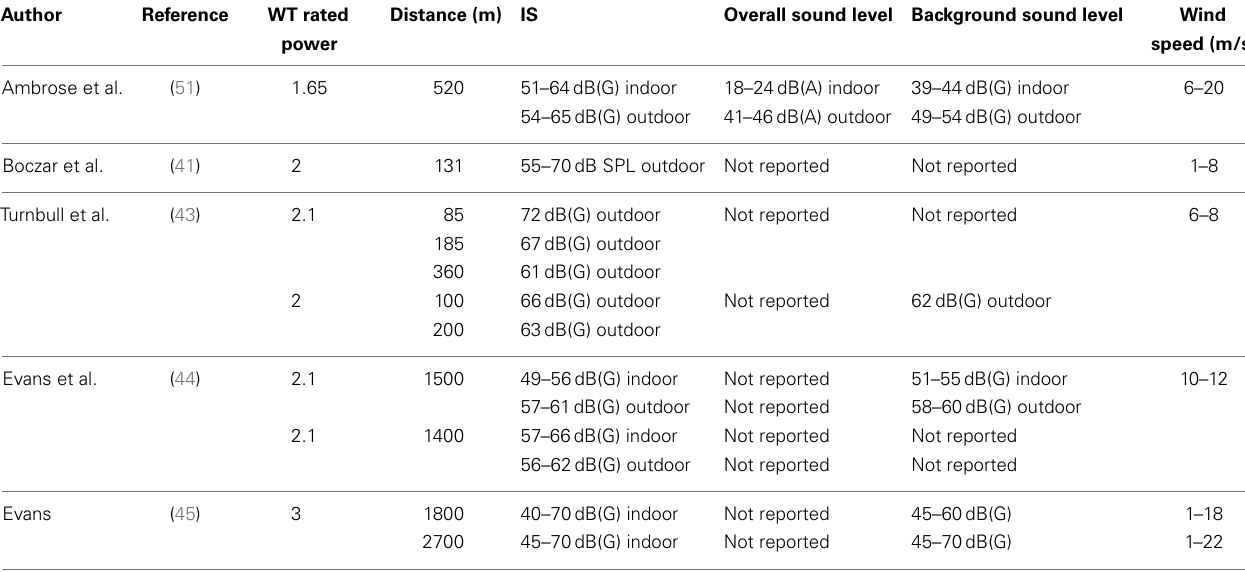
Table 2 | Review of reported wind turbine IS emissions (reported after 2010 a ) .